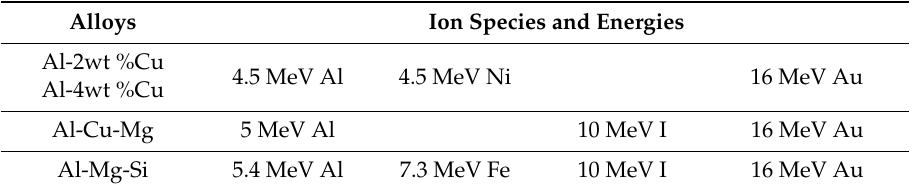
Table 2. Ion species and energies.